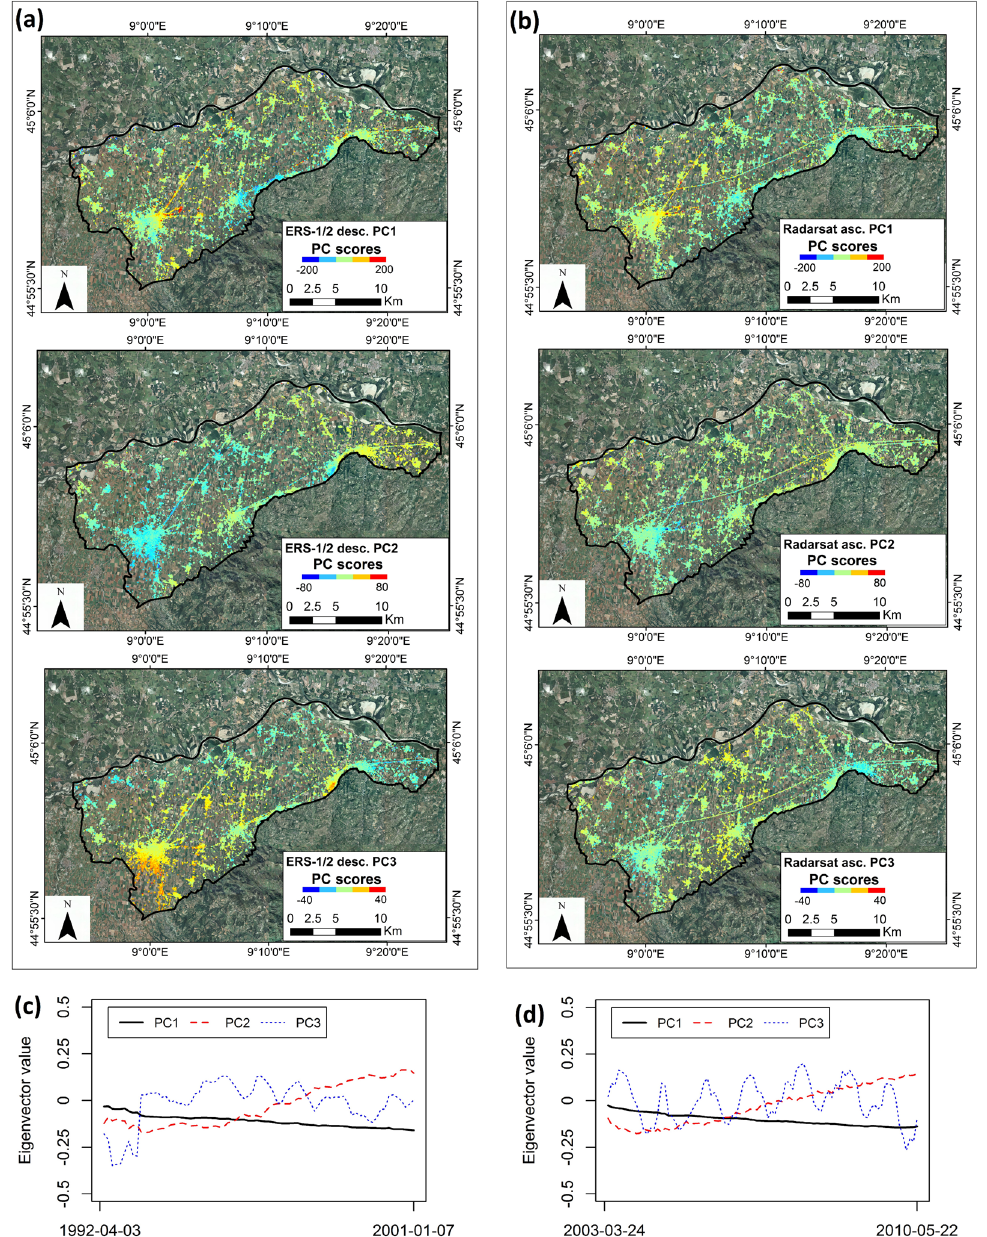
Figure 5. Principal component score maps for the period 1992–2000 ( a ) and 2003–2010 ( b ). Eigenvectors of the principal components (PC) of the ERS-1/2 desc. ( c ) and Radarsat asc. ( d ) datasets.